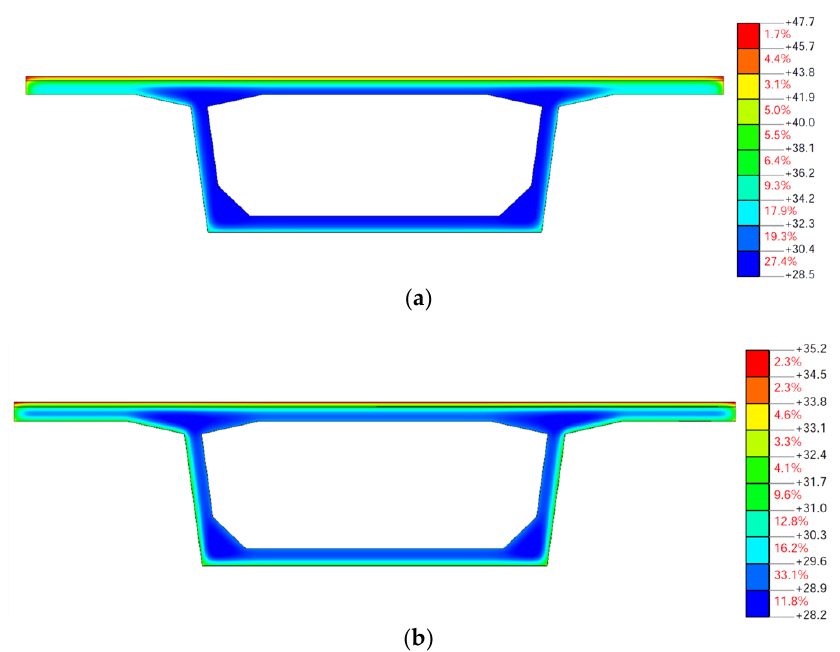
Figure 12. Temperature contour plots of box girder at 15:00 on 2 August 2010: ( a ) with solar radiation; and ( b ) without solar radiation.